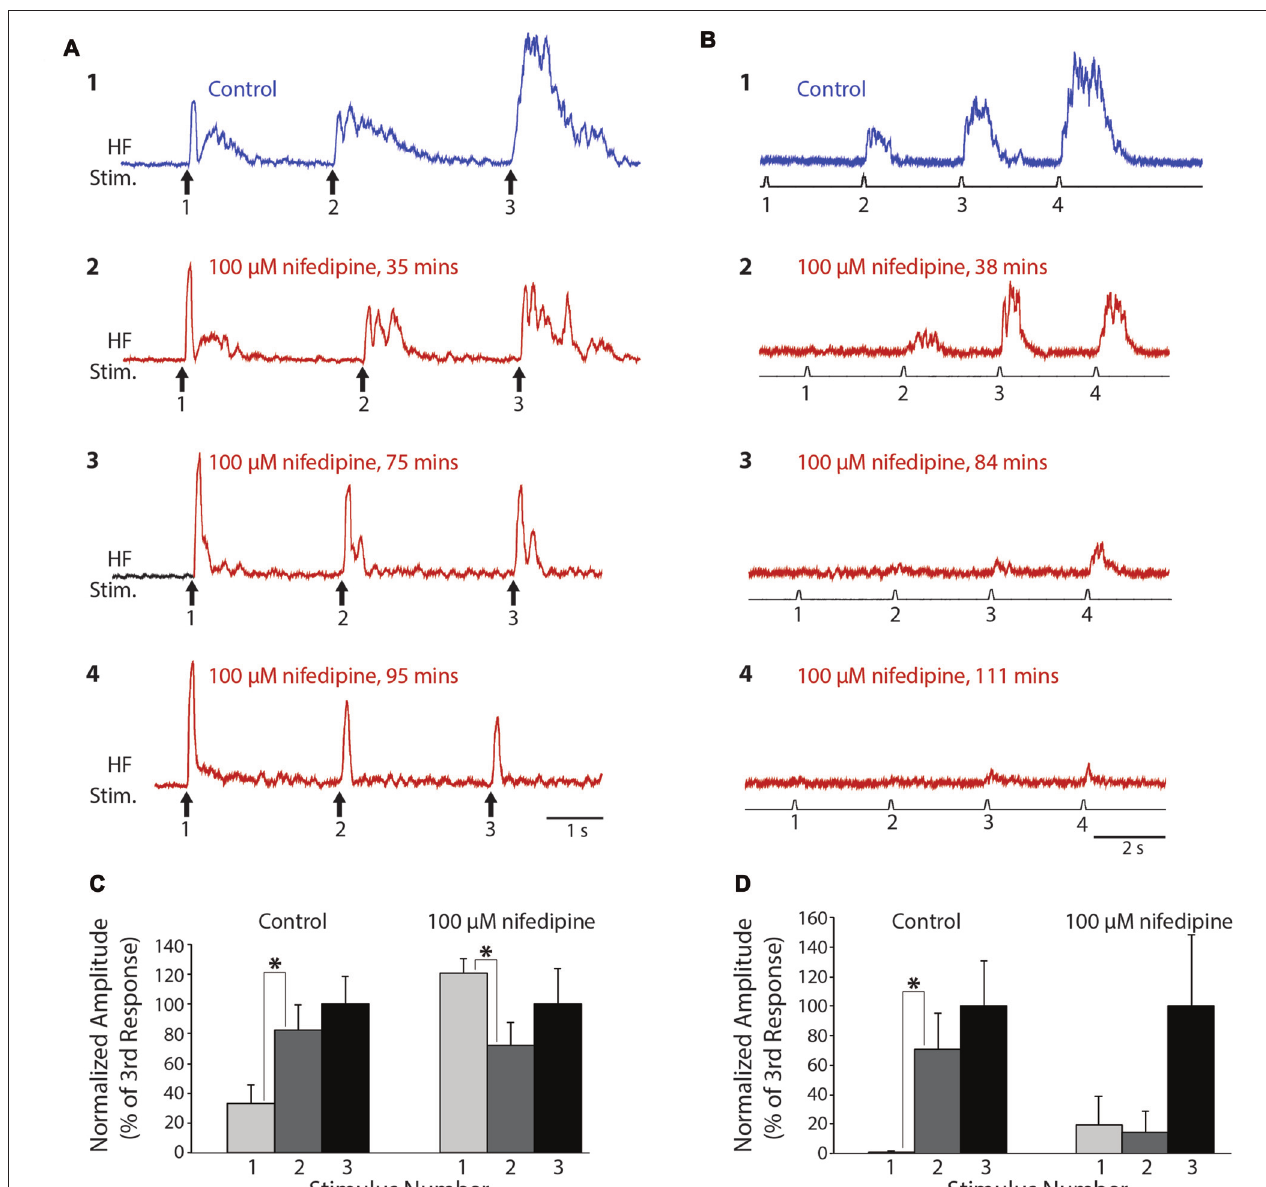
FIGURE 4 | Progressive reduction in flexion reflex windup during nifedipine application to the spinal cord. (A) Examples of windup elicited by 4-g von Frey filament taps to the dorsal hindlimb foot skin with approximately 3-s intervals in control saline (1) and during 100 µ M nifedipine application to the spinal cord (2–4) . (B) Examples of windup elicited by electrical stimulation of the dorsal hindlimb foot skin at 3-s intervals in control saline (1) and during 100 µ M nifedipine application to the spinal cord (2–4) . (C,D) Mean flexion reflex amplitude (normalized to the mean response to the 3rd stimulus in the same condition) in control saline and 100 µ M nifedipine for the animals shown in (A,B) respectively. Error bars are standard deviations. Asterisks indicate statistically significant increases in mean response amplitude between consecutive stimuli; other differences in mean responses between consecutive stimuli were not statistically significant. In (C) there